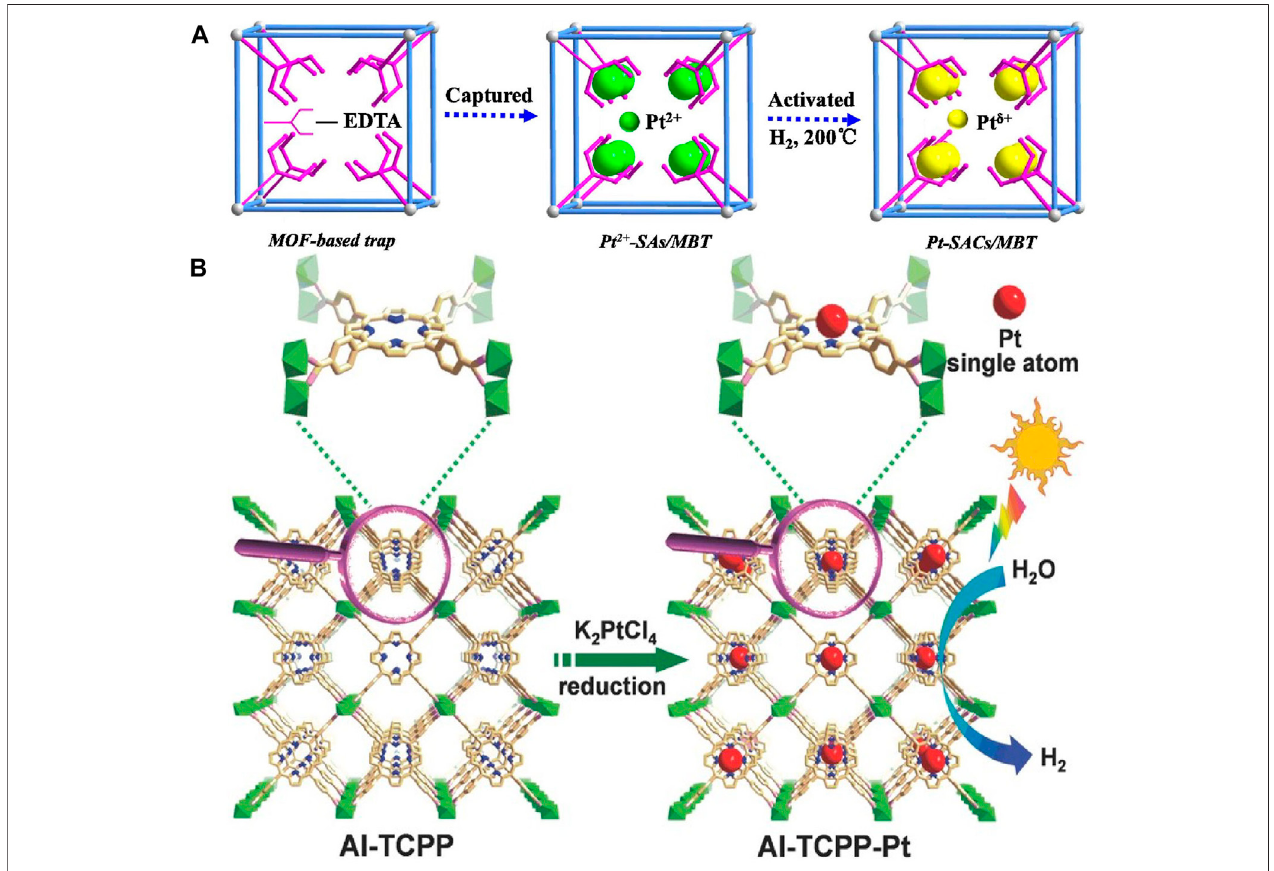
FIGURE 7 | (A) Schematic illustration of single-atom Pt catalysts encapsulated in the MOF-808-EDTA via single metal ion trap method (Li et al., 2019a). Copyright 2019, Elsevier. (B) Schematic illustration showing the synthesis of Al-TCPP-Pt for photocatalytic hydrogen production (Fang et al., 2018). Copyright 2018, Wiley.